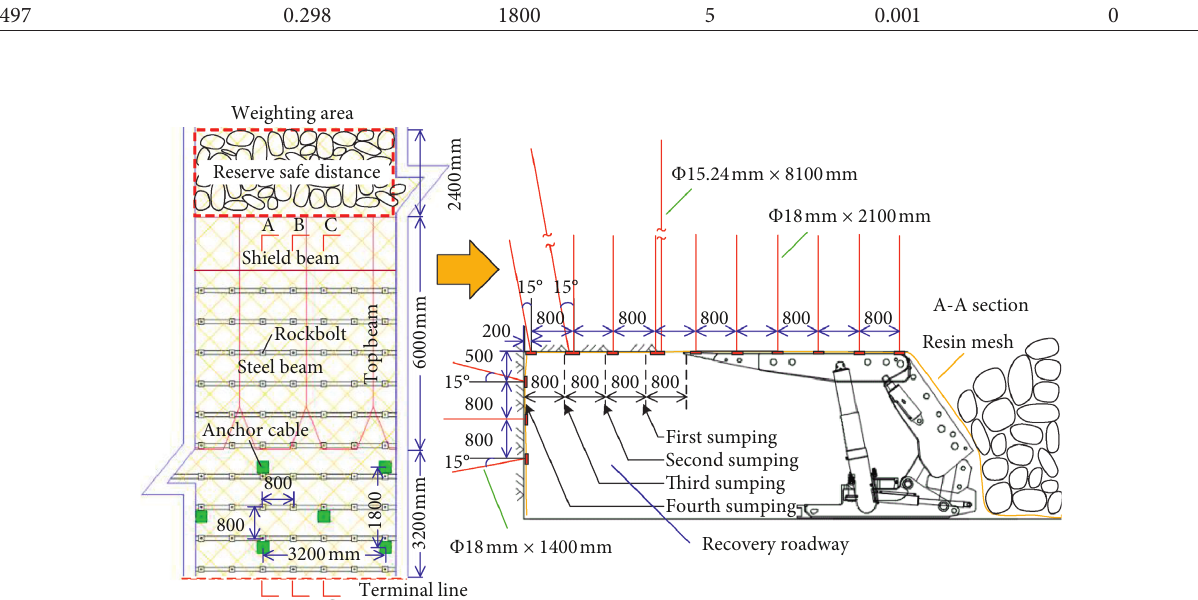
Figure 13: Initial support design of the recovery roadway in the #3-1 coal seam.